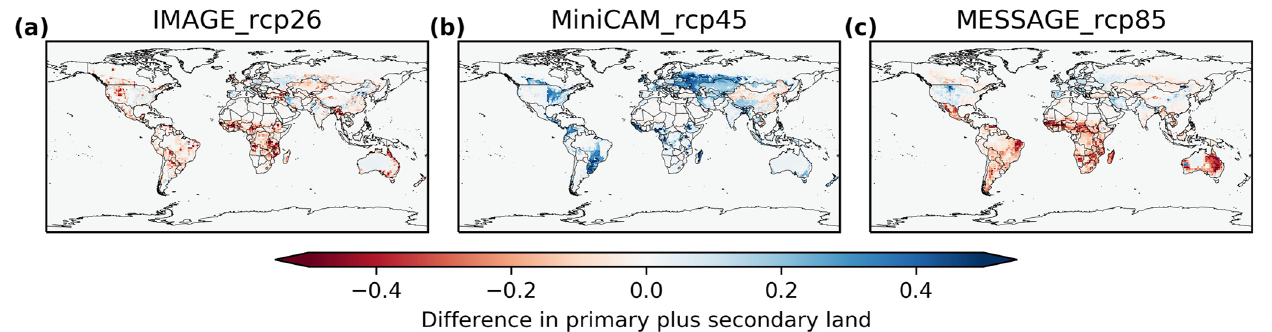
Figure 4. Change in primary plus secondary land in the rcp scenarios. The subplot titles give the acronym of the Integrated Assessment Model followed by the name of the rcp. IMAGE stands for Integrated Model to Assess the Global Environment; MiniCAM is the Mini- Climate Assessment Model; MESSAGE is the Model for Energy Supply Strategy Alternatives and their General Environmental Impact. Maps show difference between 2090–2100 and 1990–2000 according to LUH. Values are given as fraction of the land that changes its land use classification.